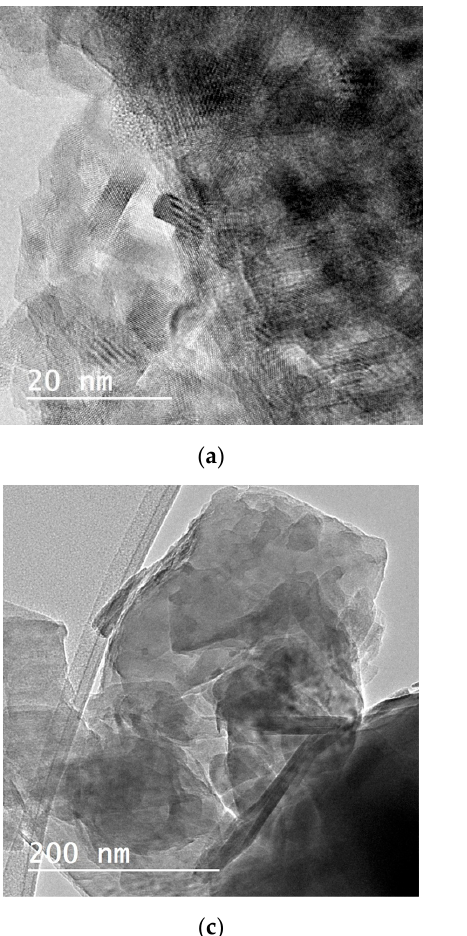
Figure 12. Dendrogram of crystallite size of outcrop samples using the Ward method and the Eu- clidean distance as measurement range. Coastal outcrops samples show higher variability in the crystallite size of quartz than those of inland outcrops. It should be noted that the red coastal cherts of the Alba for- mation (A1, C1, F1 and B3) have a larger crystallite size of quartz (2148 Å) than the red cherts analyzed of the Valdeteja and Vegamián formations. The quartz of the inland red cherts, also of the Alba Formation, show values of crystallite size equal to or greater than